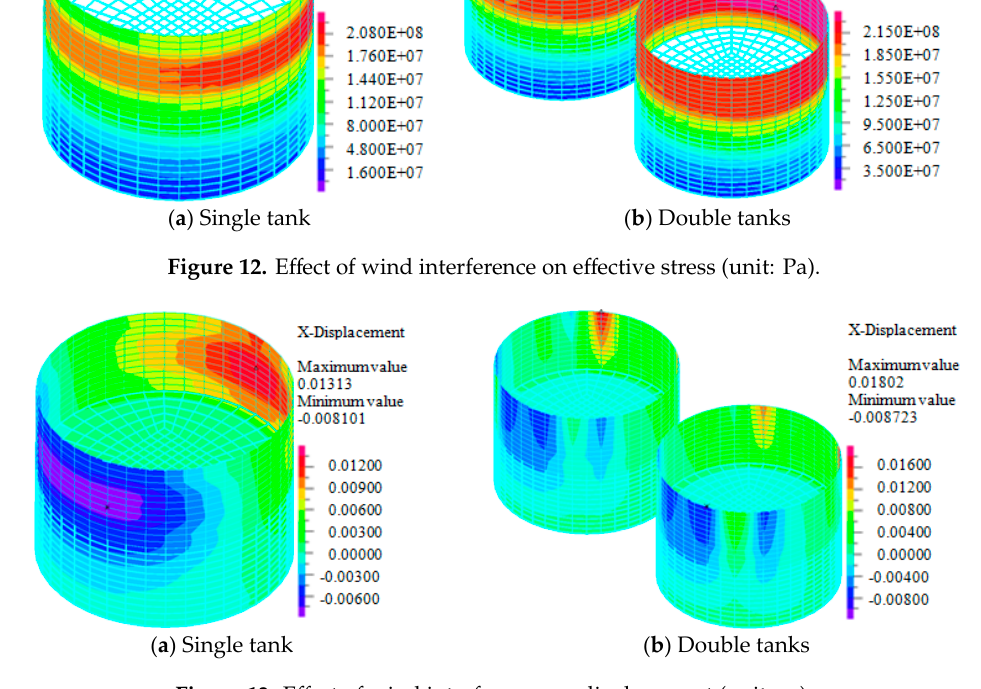
Figure 13. Effect of wind interference on displacement (unit: m).